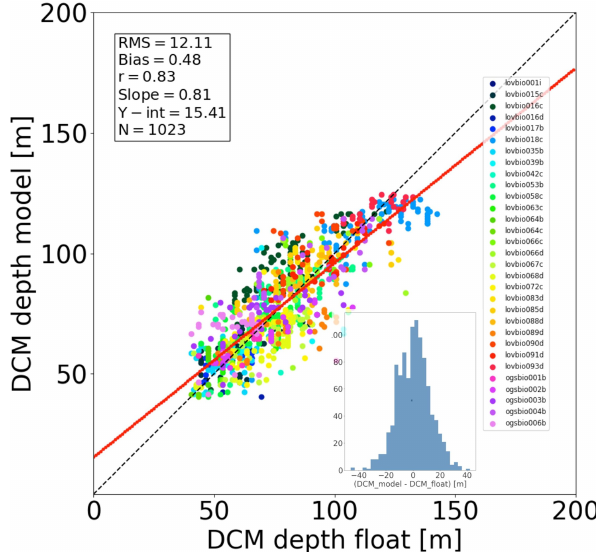
Figure 2. Match-up diagram comparing DCM depth obtained from BGC-Argo float data versus REF model results. Each dot corre- sponds to a weekly profile. The red line depicts the linear regres- sion between data and model values, defined by its slope and in- tercept ( Y -int) shown in the box. Units of RMSD, bias, and Y - int are in metres. The correlation coefficient r is significant, with p value < 0.005. The bottom sub-figure shows the residuals’ his-